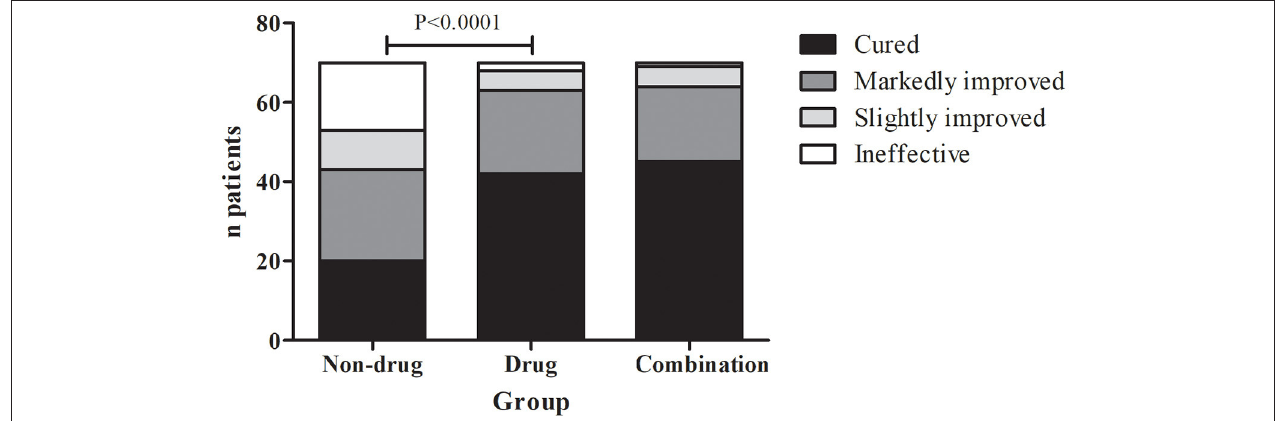
FIGURE 2 | Distribution of the treatment responses in the three groups.